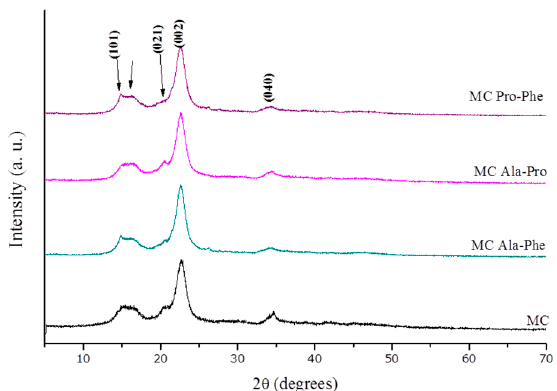
Figure 1. X-ray diffraction patterns of microcrystalline cellulose and microcrystalline cellulose loaded with amino acids.